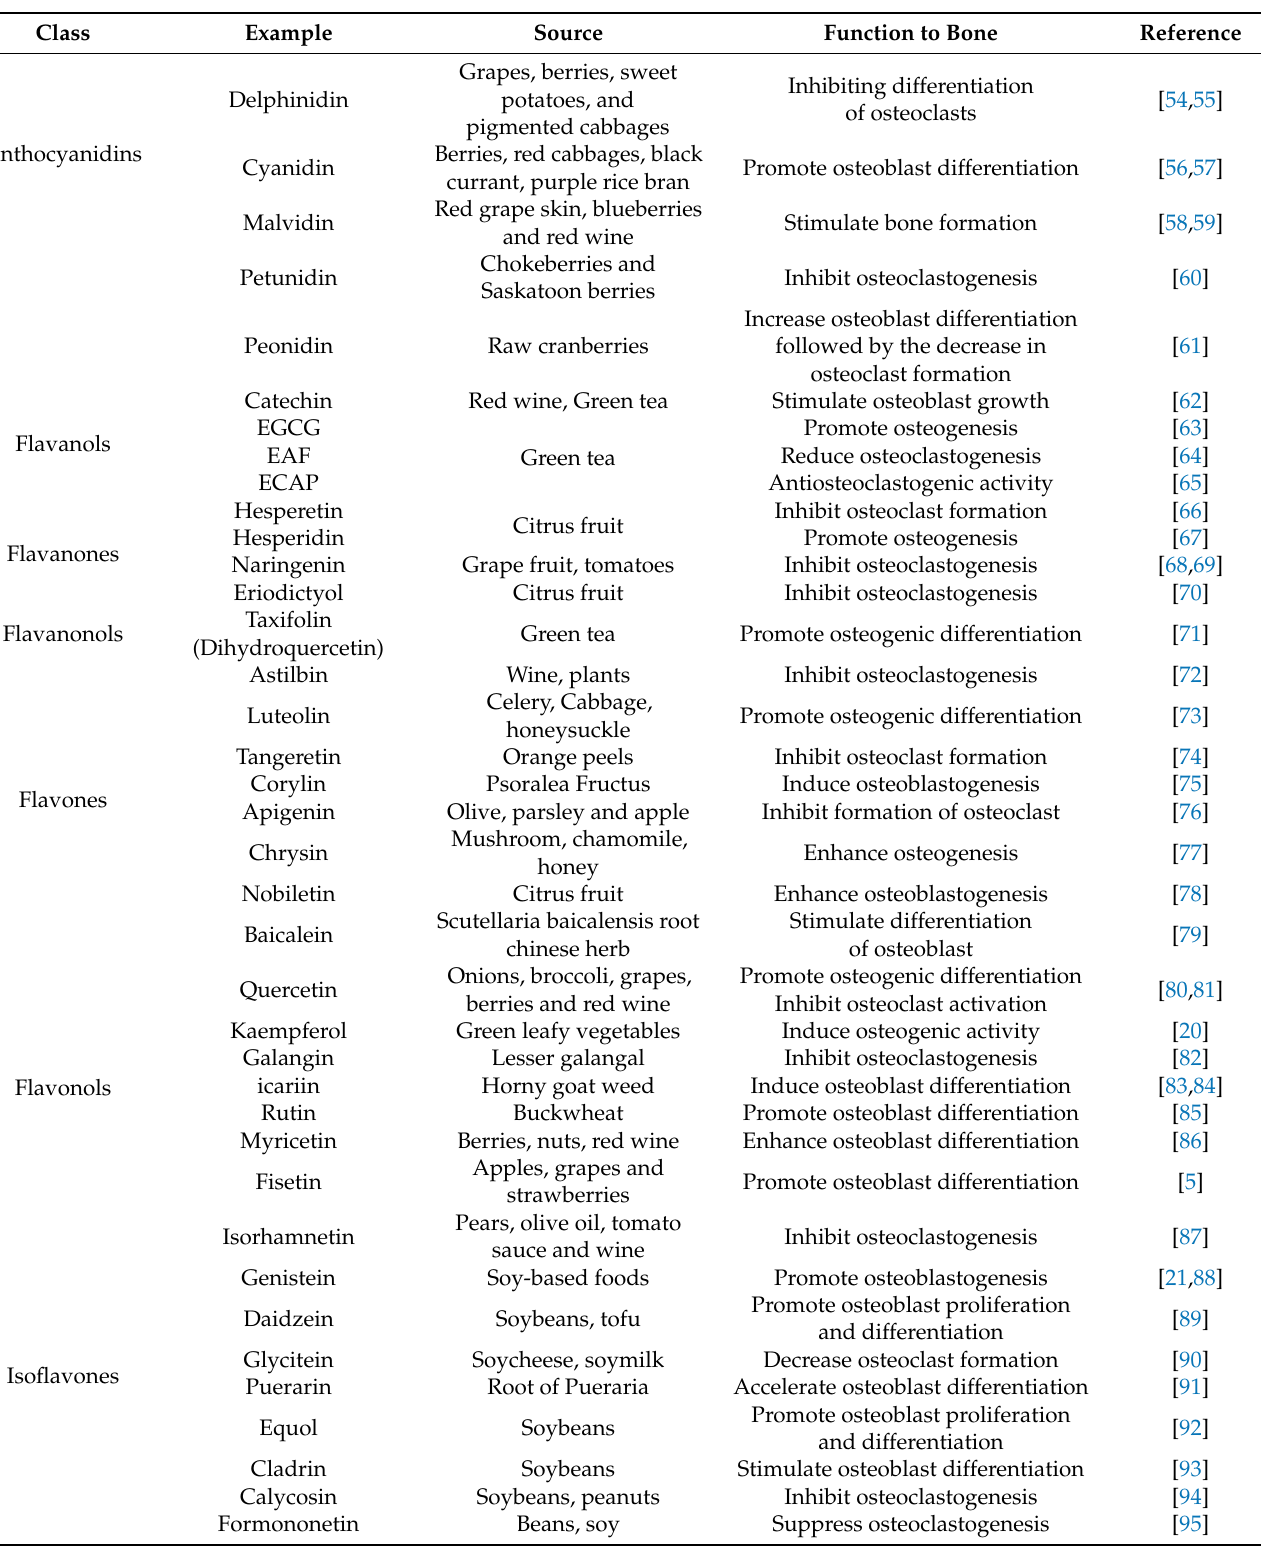
Table 1. Flavonoids and their effect on